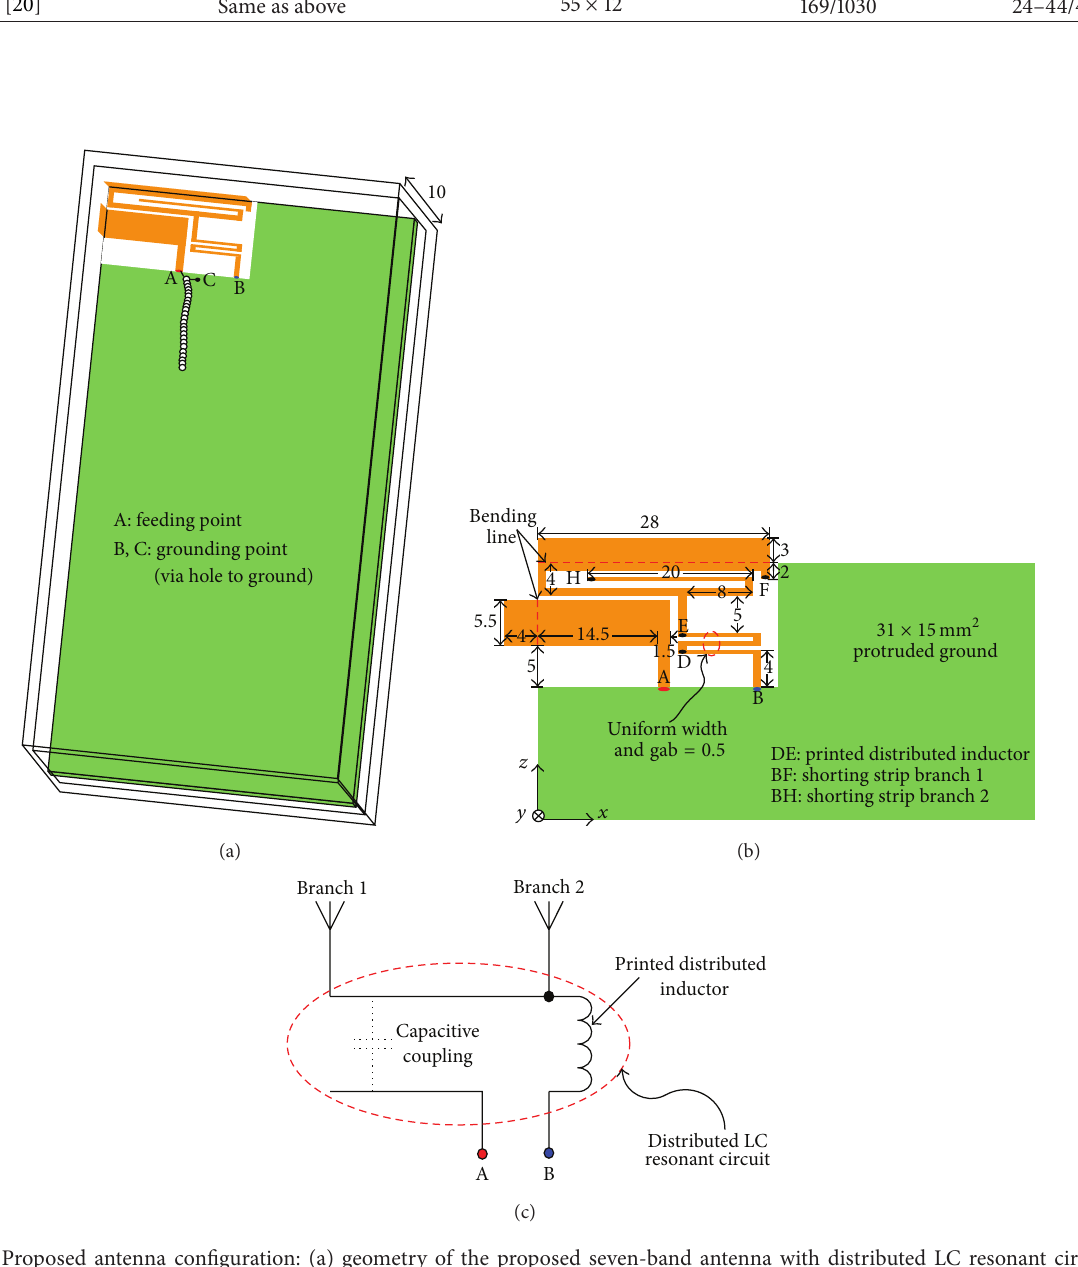
Figure 1: Proposed antenna configuration: (a) geometry of the proposed seven-band antenna with distributed LC resonant circuit. (b) Dimensions of the metal pattern in the antenna area (unit: mm). (c) Equivalent circuit diagram of the proposed